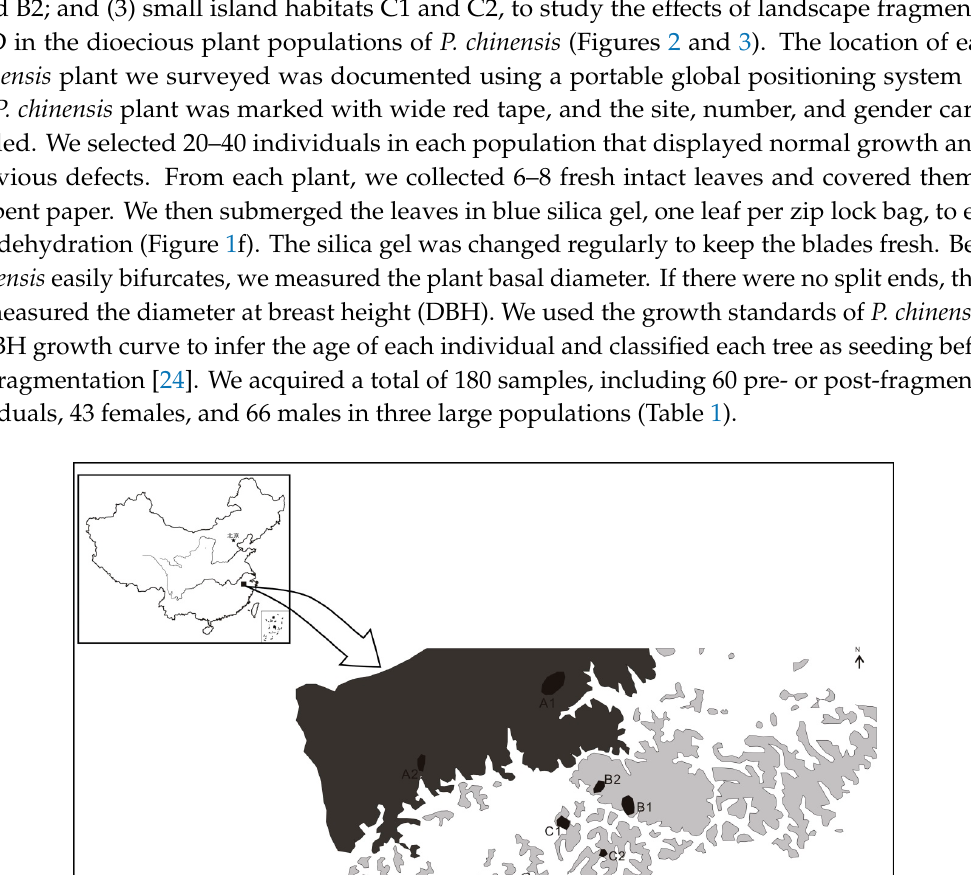
Figure 3. Isolated tree stands on islands in the Thousand-Island Lake of China. Table 1. Population size, sex ratio (male/total), and sample size of each Pistacia chinensis population, as well as the number of pre- and post-fragmentation individuals, number of males, females, and seeding individuals in the northern part of Thousand-Island Lake, China. Population